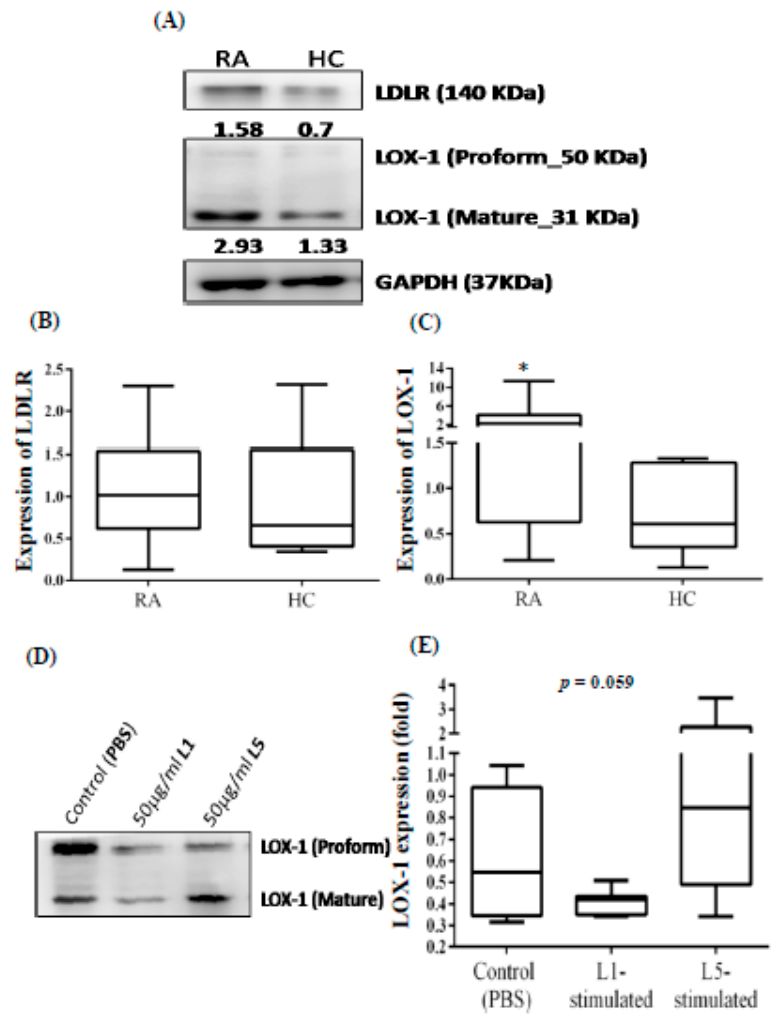
Figure 2. Increased expression of LOX-1 in PBMCs of RA patients compared with HC individuals. Representative immunoblots showed ( A ) the expression of LDLR and the receptor for L5 (LOX-1) in the PBMCs of RA patients and healthy control individuals. Quantitative comparisons are shown for the expression of ( B ) LDLR and ( C ) LOX-1 in PBMCs between RA patients and HC individuals. ( D ) Representative immunoblots showing LOX-1 expression in the lysates of THP-1 cells treated with plasma L5 or L1. Quantitative comparison is shown for ( E ) LOX-1 expression in THP-1 cells treated with control (PBS), L5, or L1. The data are presented as box-plot diagrams, in which the box encompasses the 25th percentile (lower bar) to the 75th percentile (upper bar). The horizontal line within the box indicates the median value for each group. HC: Healthy control; LDLR: Low-density lipoprotein receptor; LOX-1: Lectin-like oxidized low-density lipoprotein receptor 1; PBMCs: Peripheral blood mononuclear cells; PBS: Phosphate-buffered saline; RA: Rheumatoid arthritis. * p < 0.05 vs. healthy control individuals, determined by using the nonparametric Mann-Whitney U test.